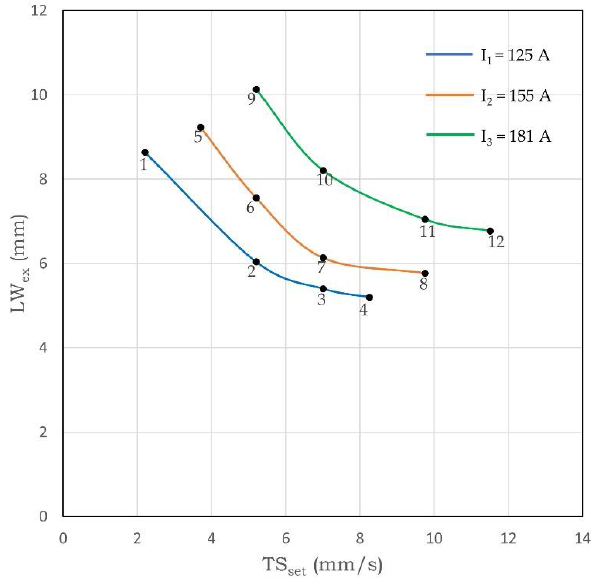
Figure 18. Maximum external LW corresponding to the 12 experiments (correspondently numbered), according to the design for the experiments (the lumped area inside the I m and TS workable limits represent the LW ex working envelope).